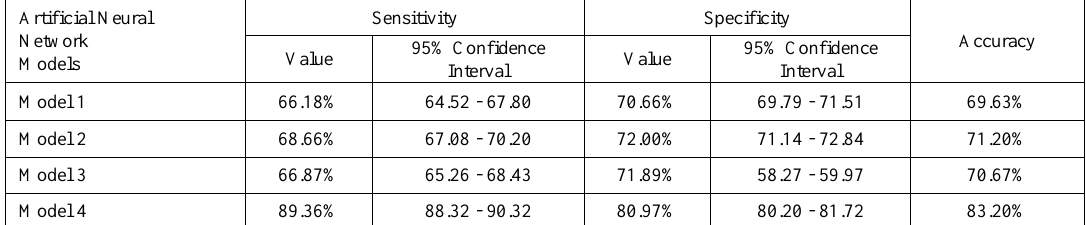
Table 4. ANN testing results: sensitivity, specificity and accuracy